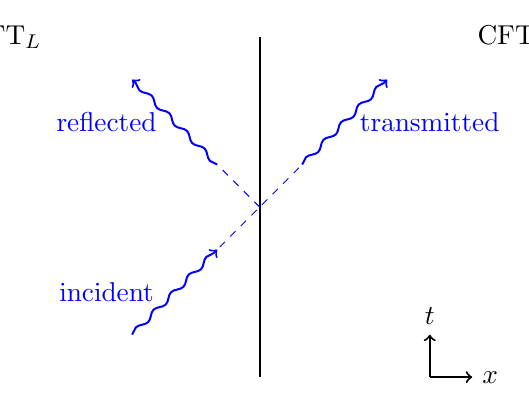
Figure 1 . The interface is the worldline of an impurity placed at x = 0, which separates a CFT L from a CFT R